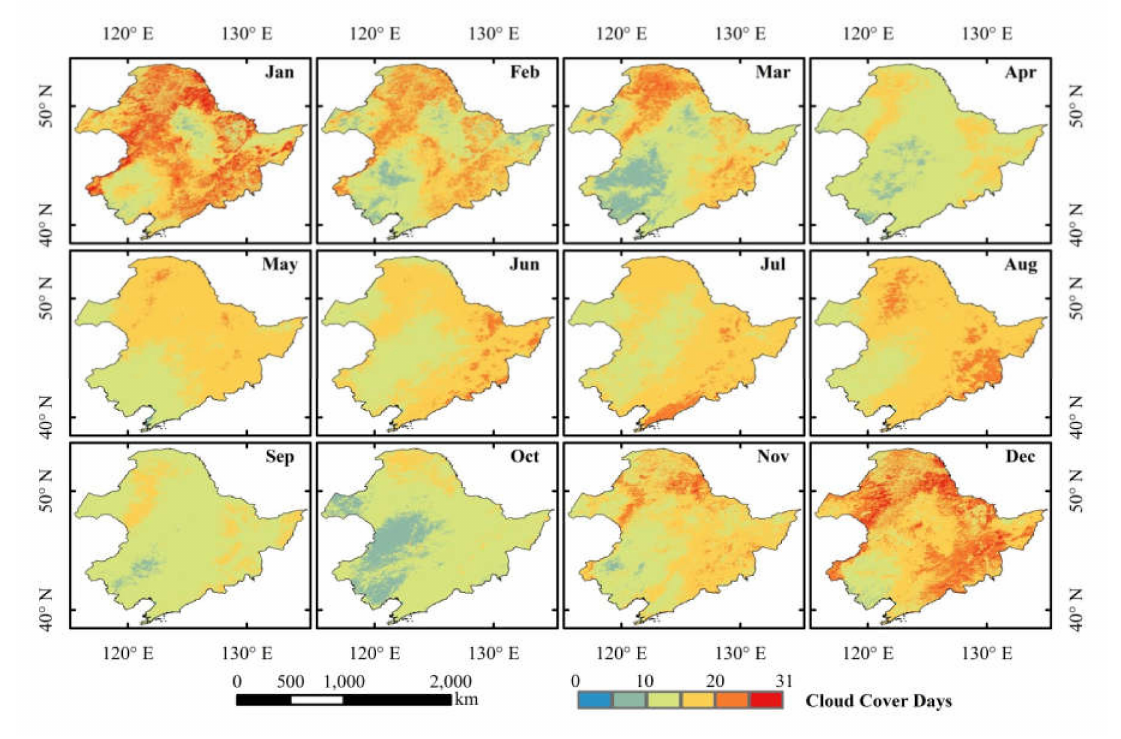
Figure 2. Average number of CCDs per month in Northeast China from 2014 to 2018, counted based on MOD10A1.